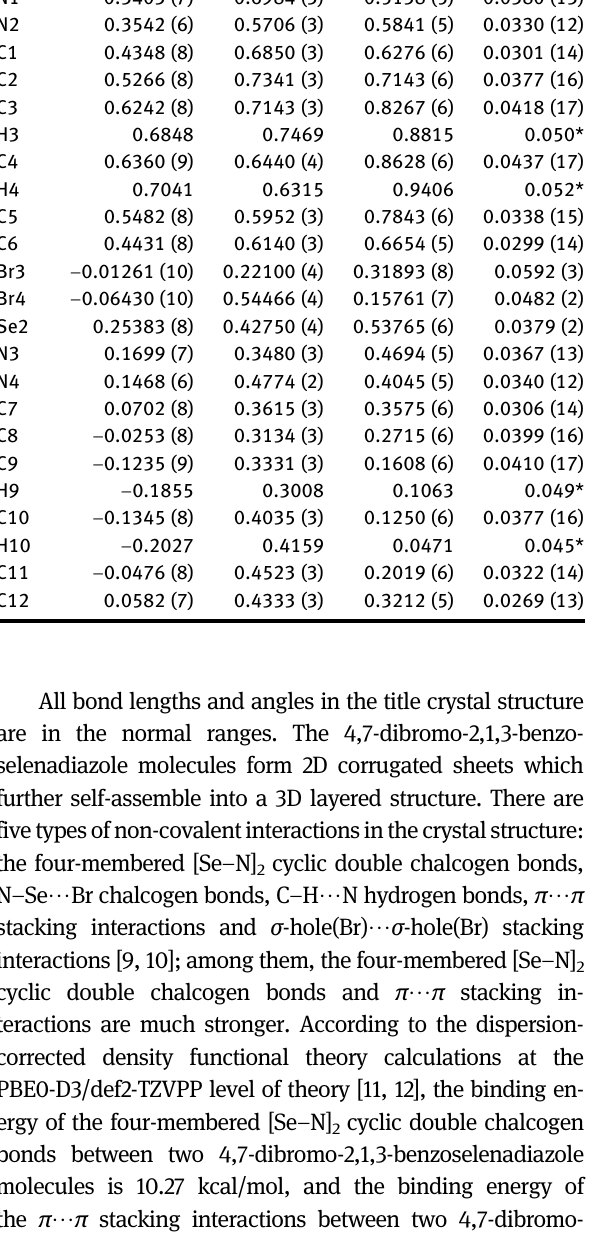
bonds between two 4,7-dibromo-2,1,3-benzoselenadiazole molecules explains why the four-membered [Se – N] double chalcogen bonds were always found in the crystals involving 2,1,3-benzoselenadiazole or its derivatives. In conclusion, there are two types of chalcogen bonds